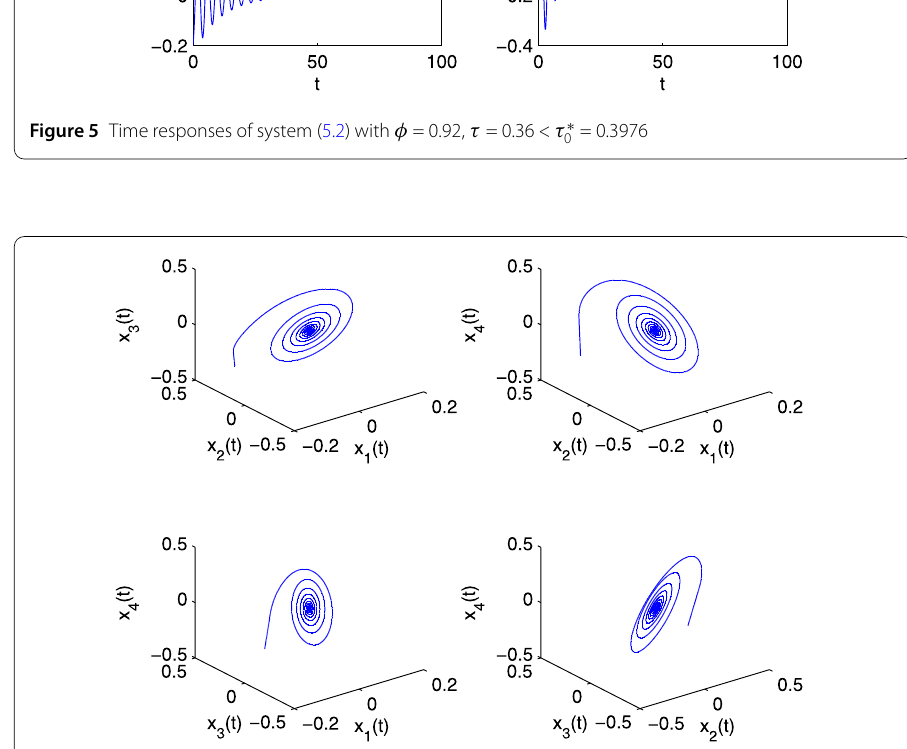
Figure 6 Phase diagrams of system (5.2) with φ = 0.92, τ = 0.36 < τ ∗ 0 =